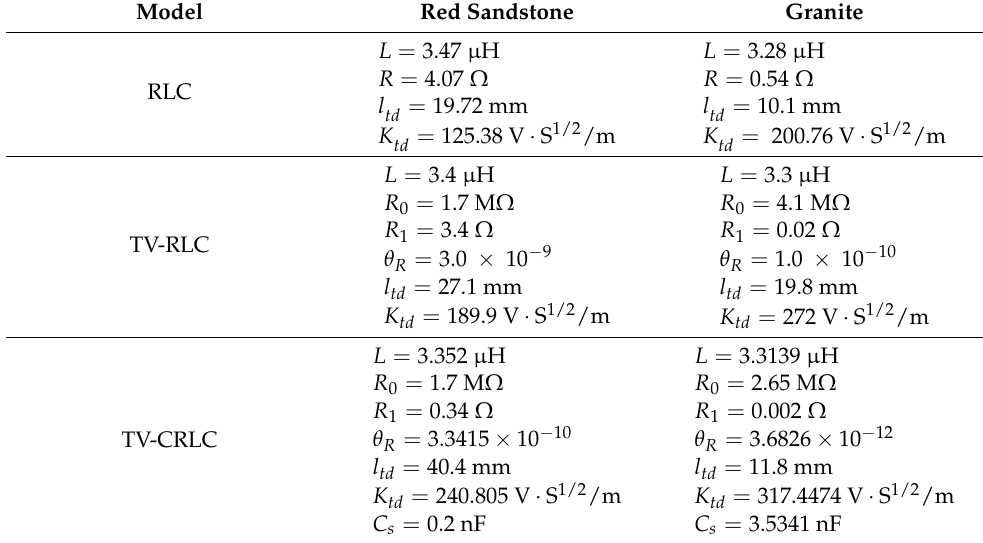
Table 1. Parameter identification results of RLC, TV-RLC, and TV-CRLC model.